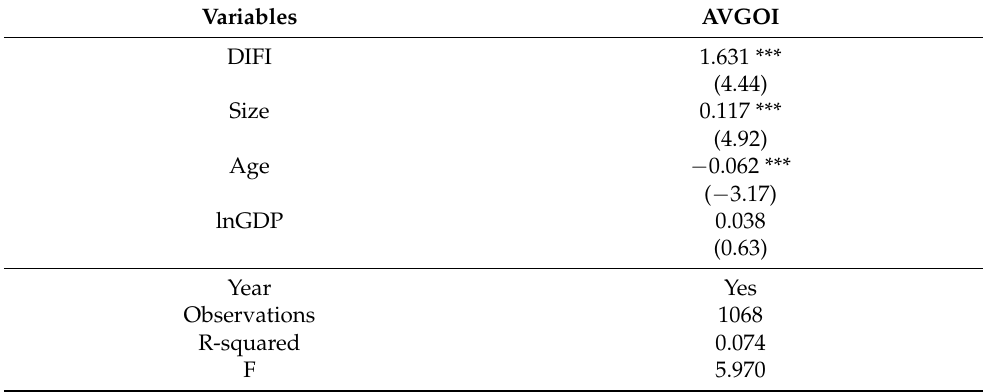
Table 3. Regression results of digital inclusive finance on operating